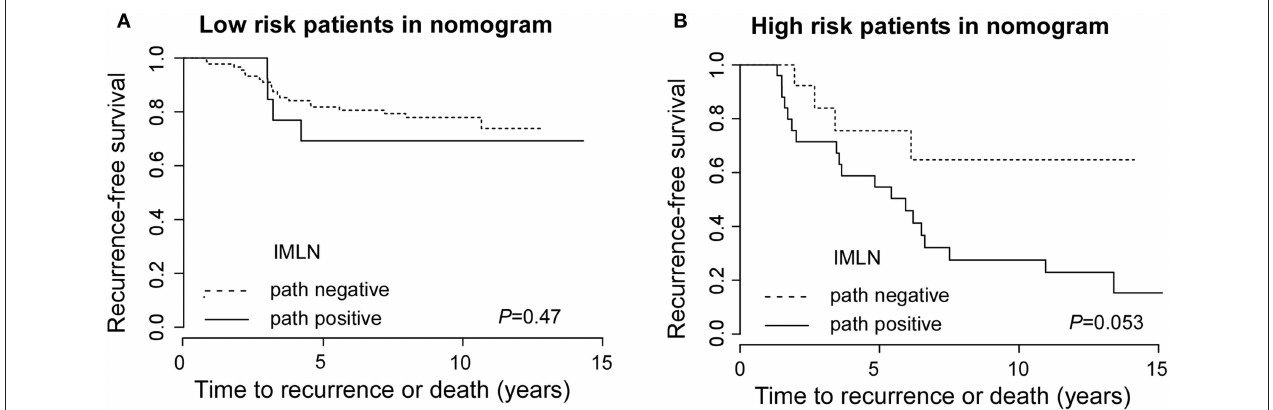
FIGURE 4 | Recurrence-free survival for low risk patients with true negative and false negative groups and for high risk patients with true positive and false positive IMLN groups. Recurrence-free survival for low risk patients (A) with true negative and false negative groups and for high risk patients (B) with true positive and false positive IMLN